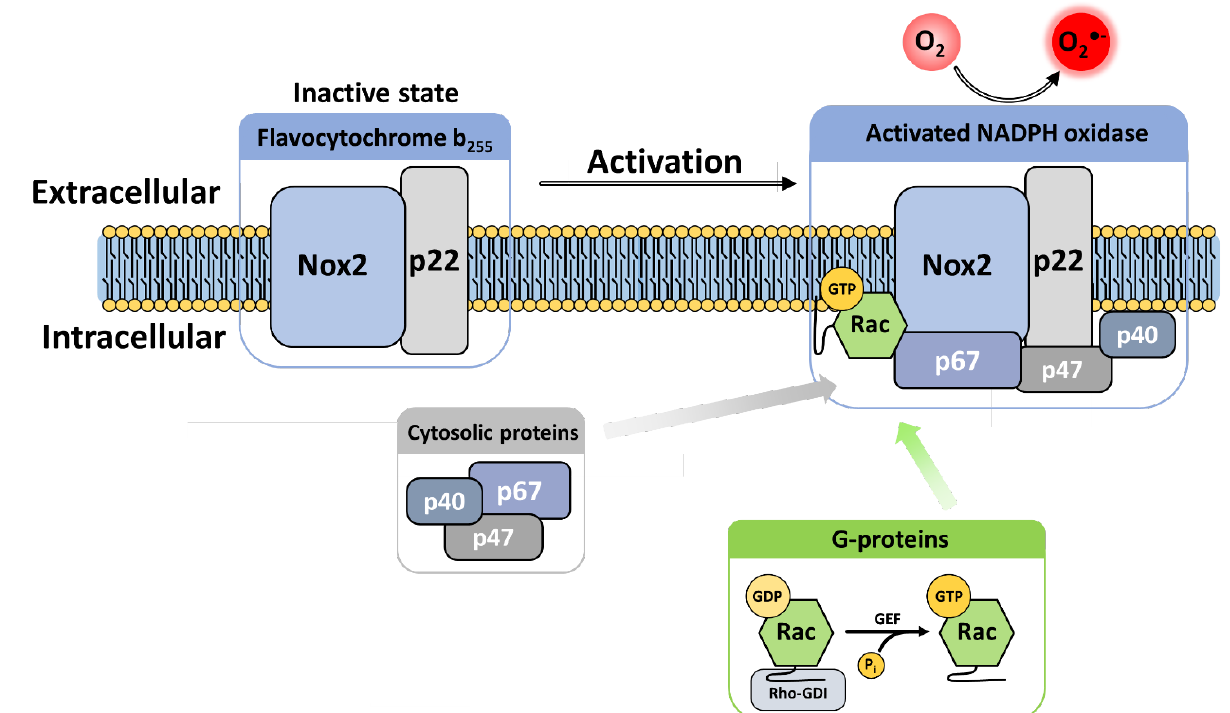
Figure 3. Activation process of the phagocytic NADPH oxidase. Detection of a pathogen triggers signaling pathways that lead to the phosphorylation of the cytosolic factors (mainly p47 phox ), inducing their translocation to the membrane-bound components of NOX2 and initiating the catalysis of superoxide production. Similarly, Rac-GDP sequestered in cytosol by RhoGDI is transferred to the membrane and its GDP exchanged for GTP for final assembly with p67 phox , leading to NOX2 activation.